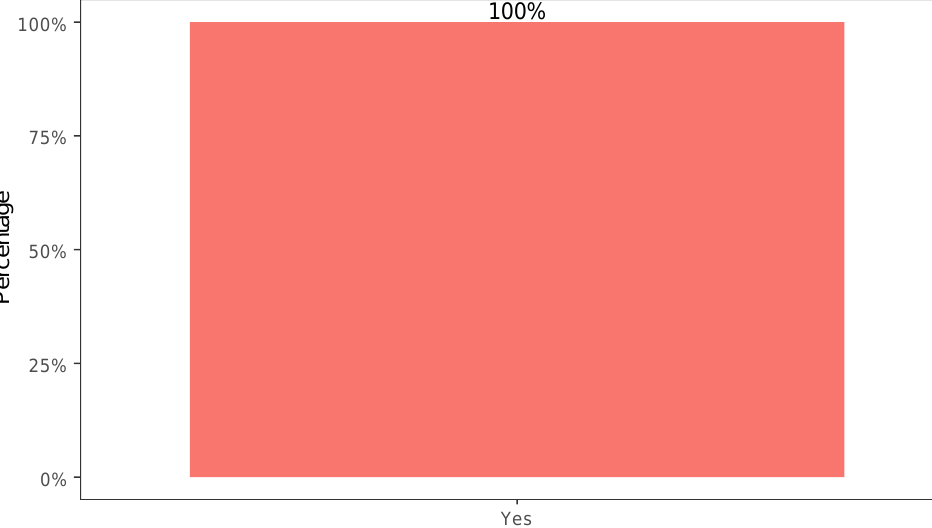
Figure 1. Internet Access among Students